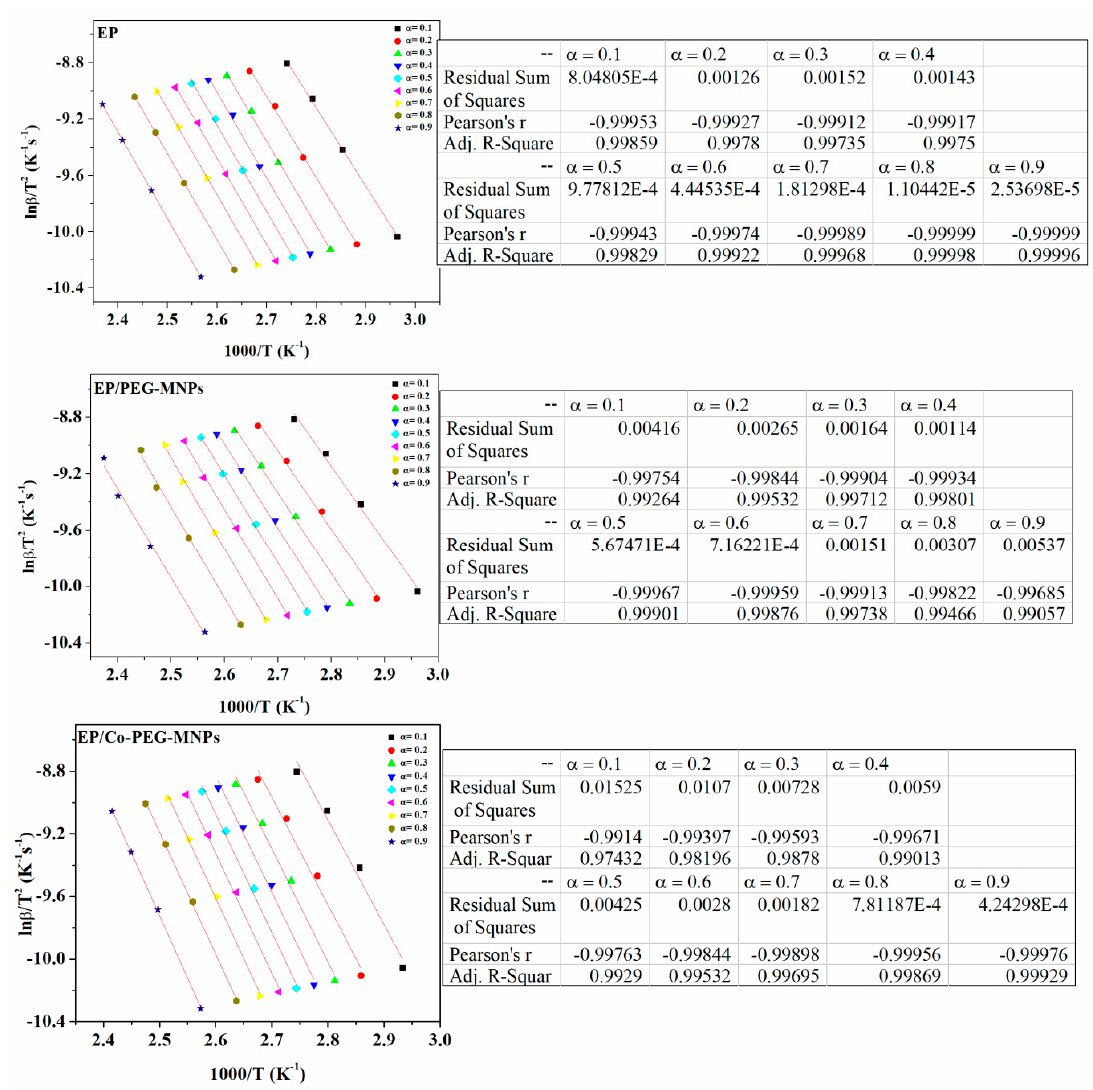
Figure A2. Arrays of ln ( β /T 2 ) plots vs. 1/T as typical plots obtained for the studied samples using KAS model.